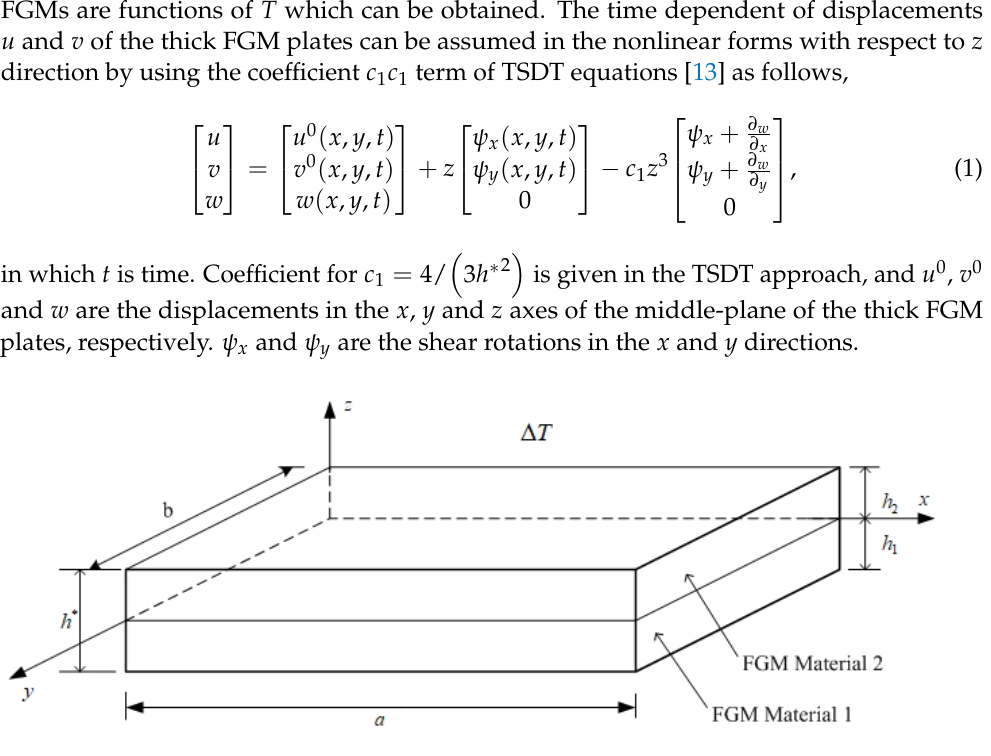
Figure 1. Thick FGM plate under sinusoidal applied heat loads. The stresses in normal direction ( σ x and σ y ) and in the shear direction ( σ xy , σ yz and σ xz ) for the thick FGM plate under temperature difference ∆ T can be obtained and expressed in terms of the products of stiffness and strains with thermal coefficients x α and α . The parameter T ∆ between the thick FGM plate and the curing environ- ment area can be obtained in linear form with z , also in sinusoidal form with x , y and t that can be expressed by Hong as follows [10], ∆𝑇𝑇 = � 𝑧𝑧 ℎ ∗ 𝑇𝑇� 1 𝑠𝑠𝑠𝑠𝑠𝑠 �𝜋𝜋𝑥𝑥 𝑎𝑎 � 𝑠𝑠𝑠𝑠𝑠𝑠 �𝜋𝜋𝑦𝑦 𝑏𝑏 �� 𝑠𝑠𝑠𝑠𝑠𝑠 ( 𝛾𝛾𝑡𝑡 ), (2) in which 𝛾𝛾 is the frequency of applied heat flux, 𝑇𝑇� 1 is the temperature amplitude of applied heat loads. The dynamic equations of motion with nonlinear TSDT for a thick FGM plate can be obtained by assuming that the first partial differentation in displacements and shear rotations with respect to z are going to zero in the strain-displacement relations [14]. The dynamic equilibrium differential equations with nonlinear TSDT of thick FGM plates could be obtained by Hong [10] with the following integrals for the stiffness